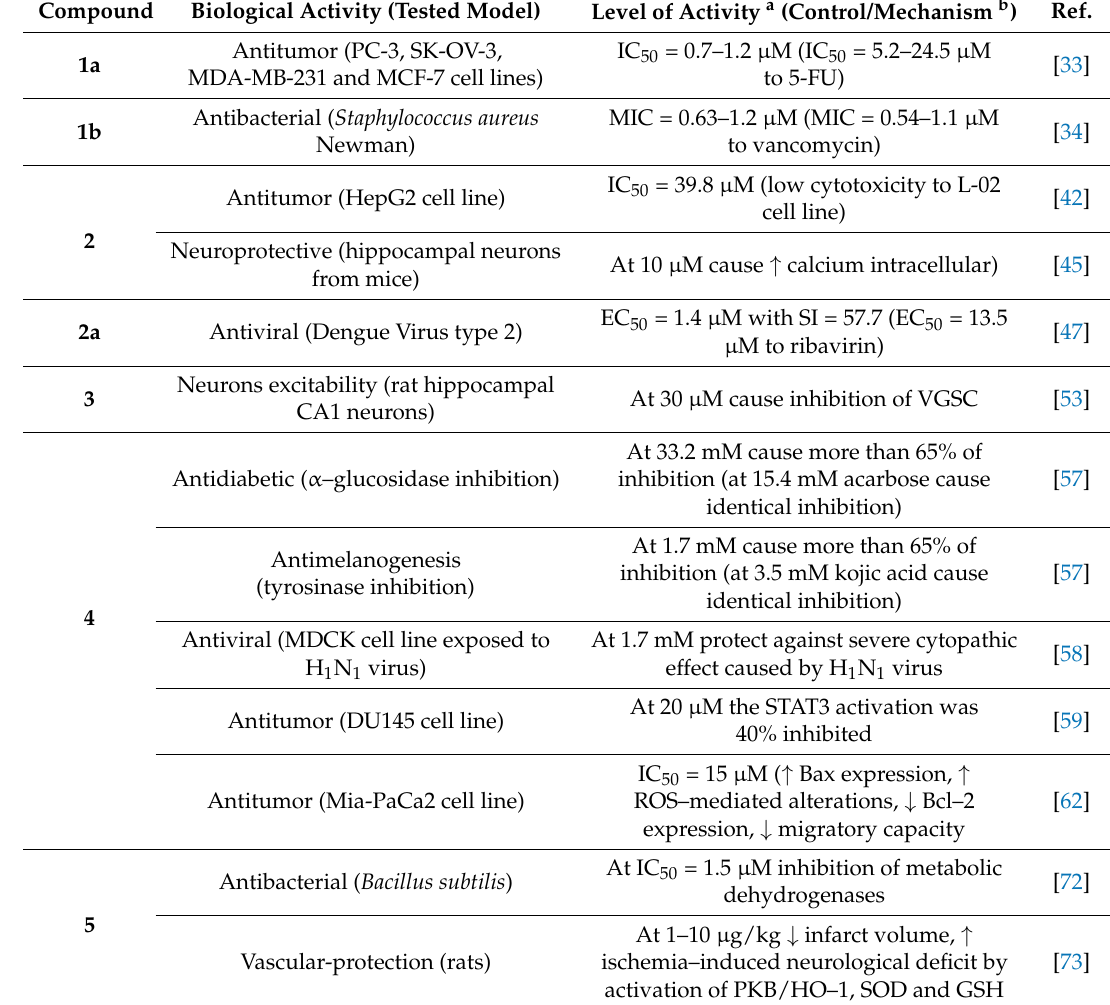
Table 1. The key points of each secondary metabolite